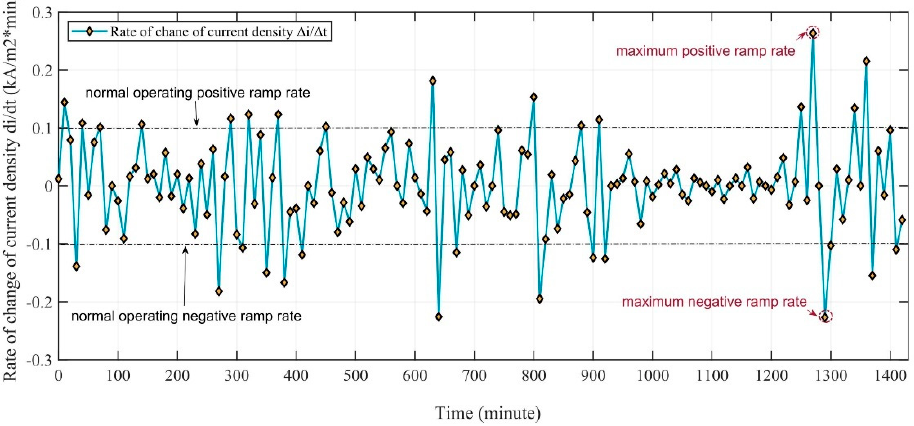
Figure 11. Simulated ramp rate profile of current density over a whole day.